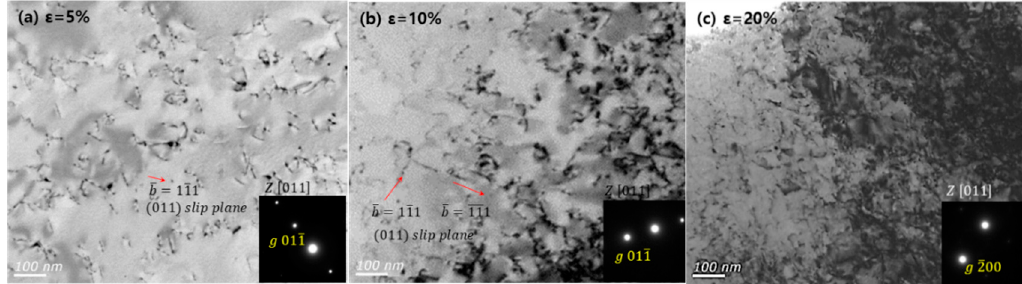
Figure 7. TEM BF images and the corresponding SAD patterns of LDX-2101 steel ferrite grains: ( a ) ε =5%, ( b ) ε =10%, ( c ) ε =20% tensile strained specimen.